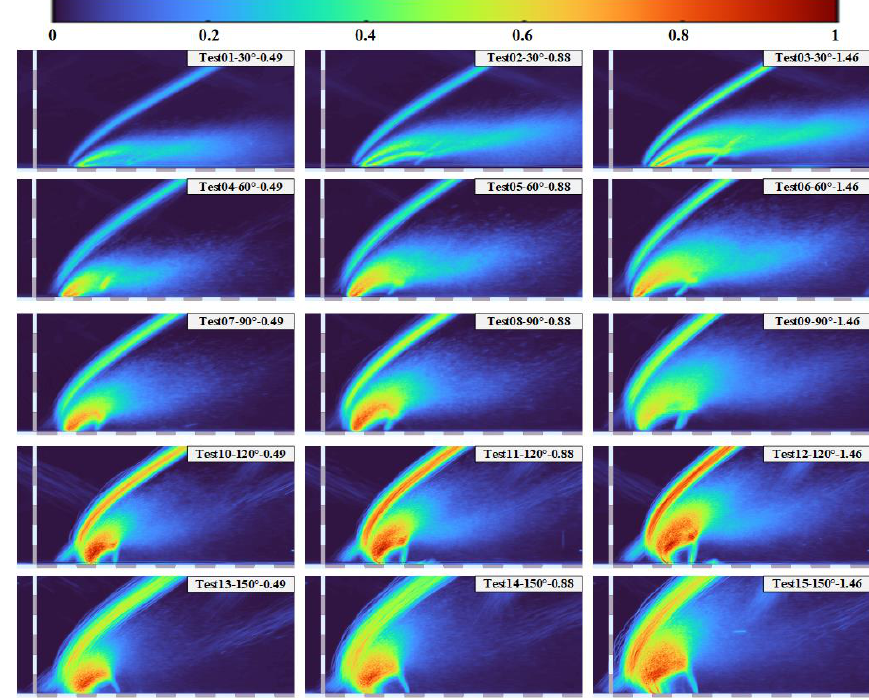
Figure 15. Diagram of flow field standard deviation (fluctuation).